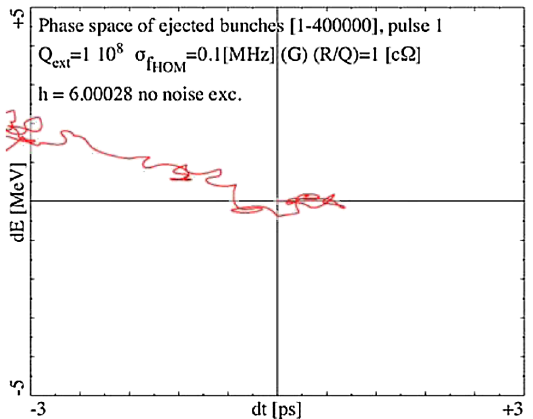
FIG. 46. (Color) Phase-space image of the ejected bunches of the second pulse. Conditions as Figs. 38 and 43 ( Q ext ¼ 10 8 ) but ð R=Q Þ ¼ 0 : 2 (cid:2)